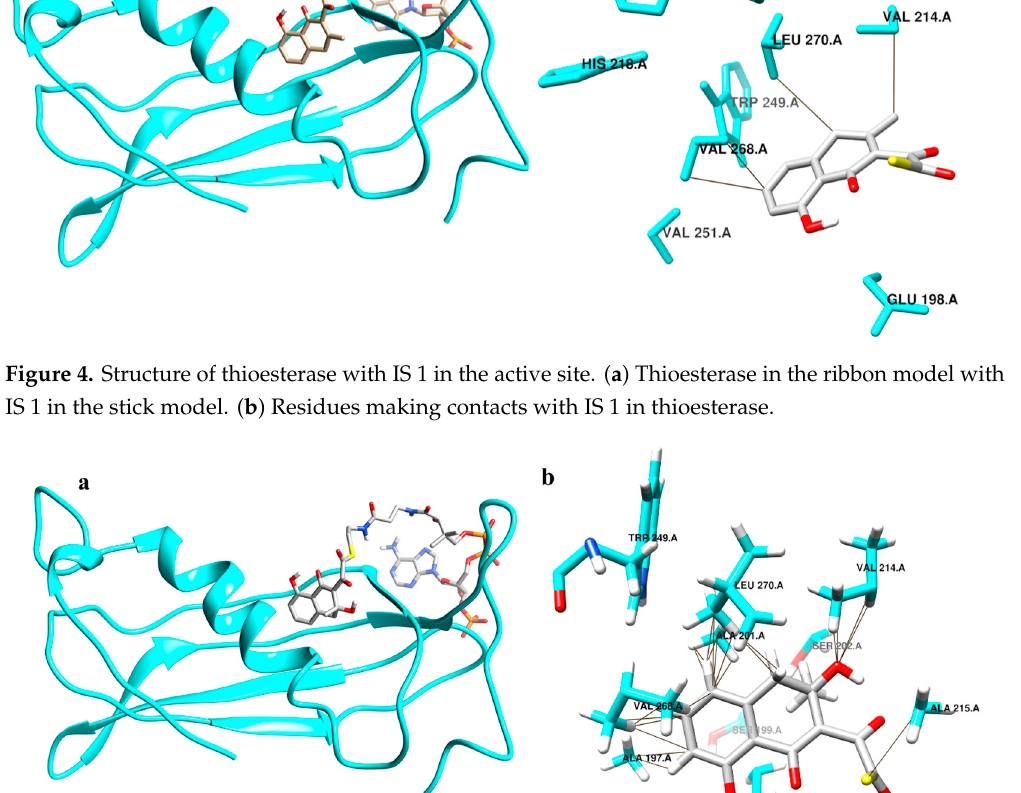
Figure 4. Structure of thioesterase with IS 1 in the active site. ( a ) Thioesterase in the ribbon model with IS 1 in the stick model. ( b ) Residues making contacts with IS 1 in thioesterase.